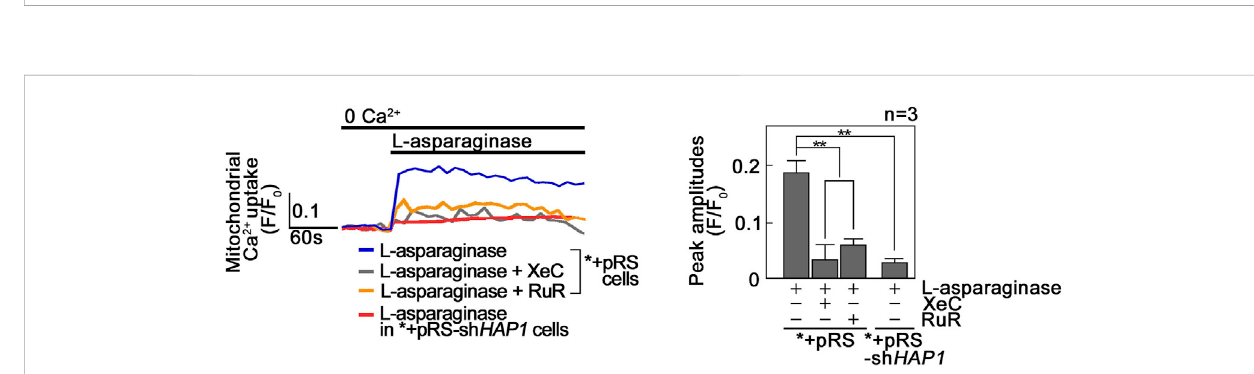
FIGURE 3 L-asparaginase causes Ca 2+ transfer from the ER to the mitochondria. *+pRS and *+pRSsh HAP1 cells loaded with Rhod-2 AM and pre-treated with XeCorRuRwerestimulatedwithL-asparaginaseandanalyzedformitochondrialCa 2+ uptakebyspectro fl uorometry.Dataontheleftisfromoneofthree independent experiments showing similar results. Peak amplitudes were quanti fi ed as ratios of fl uorescence (F/F 0 ) after addition of L-asparaginase. F 0 represents basal fl uorescence or fl uorescence before stimulation with L-asparaginase. The chart on the right shows mitochondrial Ca 2+ uptake in *+pRS and *+pRS-sh HAP1 cells treated as described above. Values are means ± SEM from the three independent experiments ( n = 3). ** p <